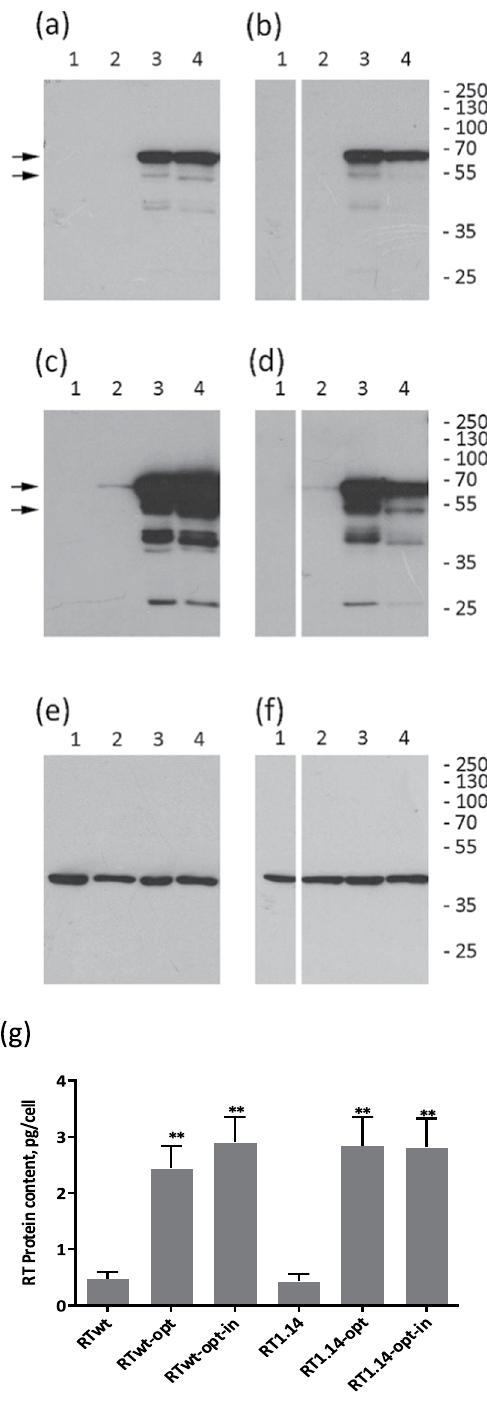
Figure 1. Expression of RT variants in eukaryotic cells. ( a – f ) Western blotting of the lysates of HeLa cells transfected with vector pVax1 (lane 1), and pVax-based plasmids expressing RTwt (lane 2 a,c,e), RTwt-opt (lane 3 a,c,e), RTwt-opt-in (lane 4 a,c,e), RT1.14 (lane 2 b,d,f), RT1.14-opt (lane 3 b,d,f), and RT1.14-opt-in (lane 4 b,d,f). Blots of RTwt and RT1.14 variants were processed in parallel. Blots were stained with rabbit polyclonal anti-RT antibodies 59 ( a – d ) and then stripped and re-stained with monoclonal anti-actin antibodies. ( e , f ) Positions of the relevant molecular mass markers are given to the right in kDa. Arrows point at the p66 and p51 RT subunits. Panels (a,b) represent results of a 0.5 min exposure of X-ray film with a blot, while panels (c,d) represent results of a 10 min exposure. Full-length blots are presented in Supplementary Fig. 2. ( g ) The average amount of RT protein expressed per HeLa cell transfected with RT variant genes. ** p < 0.01 (as compared to non-optimized RT variants) using the Mann–Whitney U-tests. The graph represents the results of three independent runs, each done in duplicate, and the error bars represent the